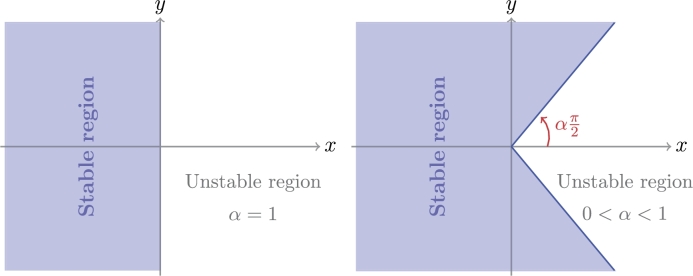
Stability region of the fractional-order system.